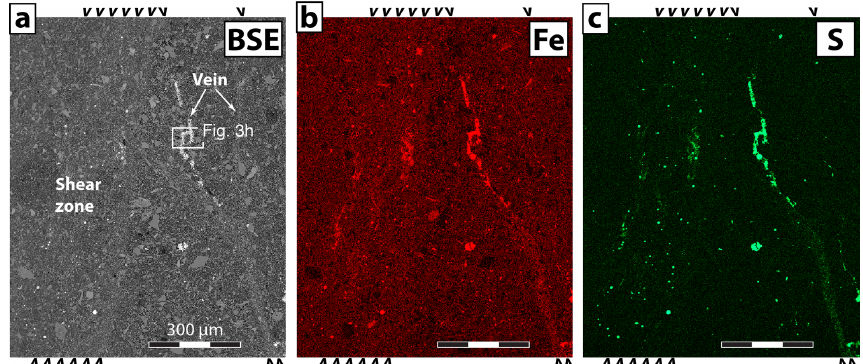
Figure 5. Example of SEM map in a shear zone and a vein (sample 21R-2, 82-85), showing the greater modal abundance of pyrite crystals in deformation bands (represented by arrows) relative to the host sediment matrix. (a) Back-scattered electron picture. (b, c) Fe and S maps, respectively.